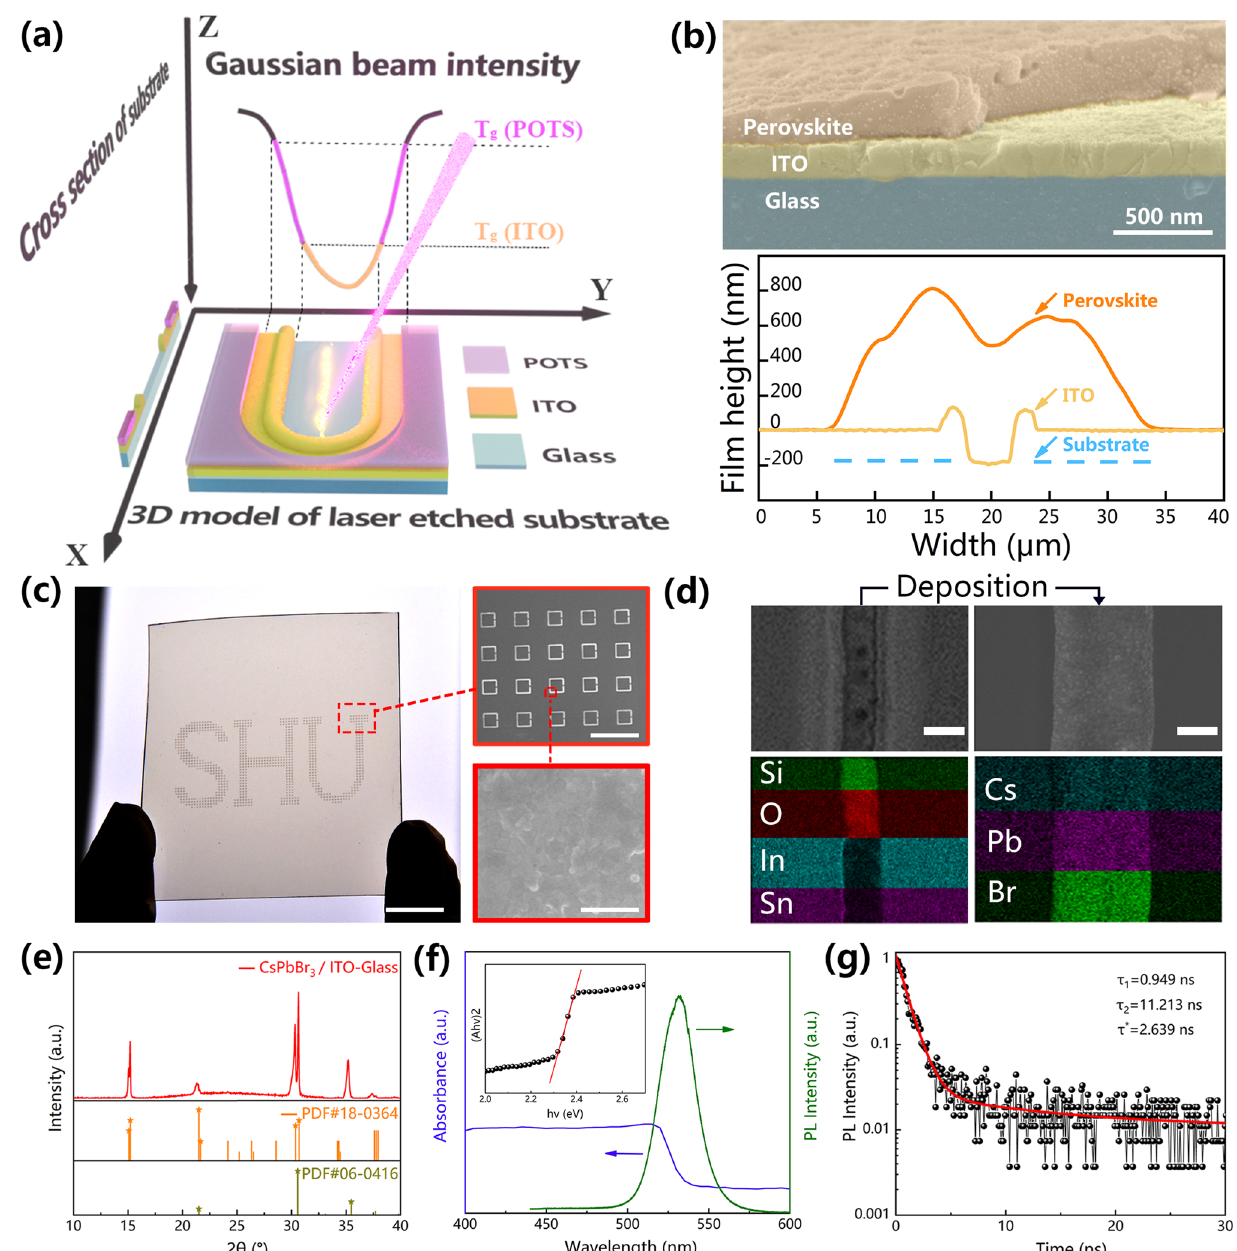
Fig. 3 a Schematic diagram of the mechanism of laser etching. The XY and XZ planes showed the 3D and cross-sectional views of the etching effect, respectively. The YZ plane showed the Gaussian distribution of the laser beam intensity. b The cross section SEM image of the perovs- kite-deposited ITO-glass. The surface profile of the ITO-glass after laser etching and the perovskite-deposited ITO-glass shown in the bottom graph. c An optical image of the perovskite film array patterned as “SHU” on the glass substrate (scale bar: 1 cm). The inset showed the SEM image of part of the perovskite array (scale bar: 600 μm) and enlarged view of film (scale bar: 1 μm). d The top and bottom pictures severally were SEM and EDS mapping images of the substrate before (left) and after (right) perovskite deposition. The scale bar is 8 μm. e XRD spectra of the perovskite array. f The PL and absorption spectra of CsPbBr 3 . The inset showed the spectrum for calculating the optical band gap. g A time-resolved PL spectroscopy curve of the CsPbBr 3